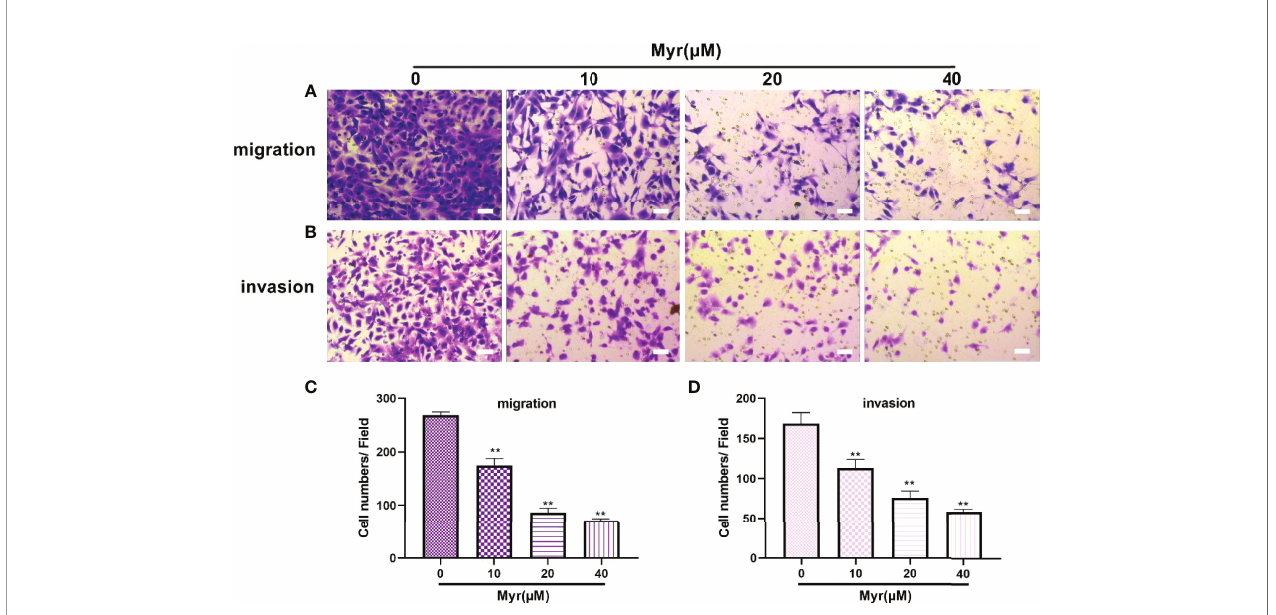
FIGURE 4 | Effects of different concentrations of Myr on SKOV3 migration and invasion. After treating SKOV3 cells with Myr at 0, 10, 20 and 40 m M for 24 h, migration (A, C) and invasion (B, D) were determined using Transwell assays and microscopy at ×100 magni fi cation. n=3; ** p < 0.01 vs. control.